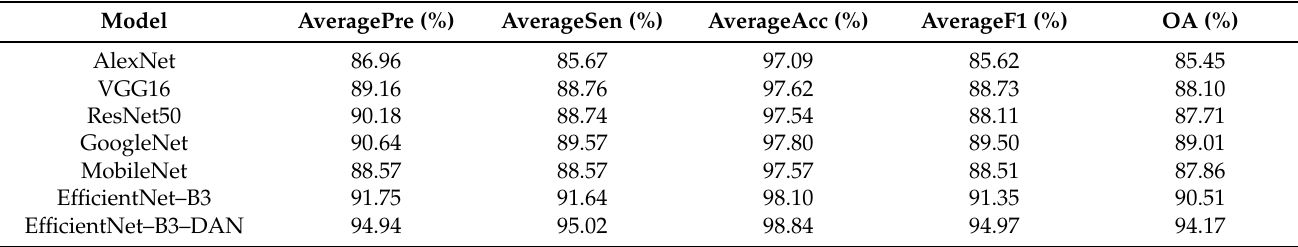
Table 4. Evaluation metrics of